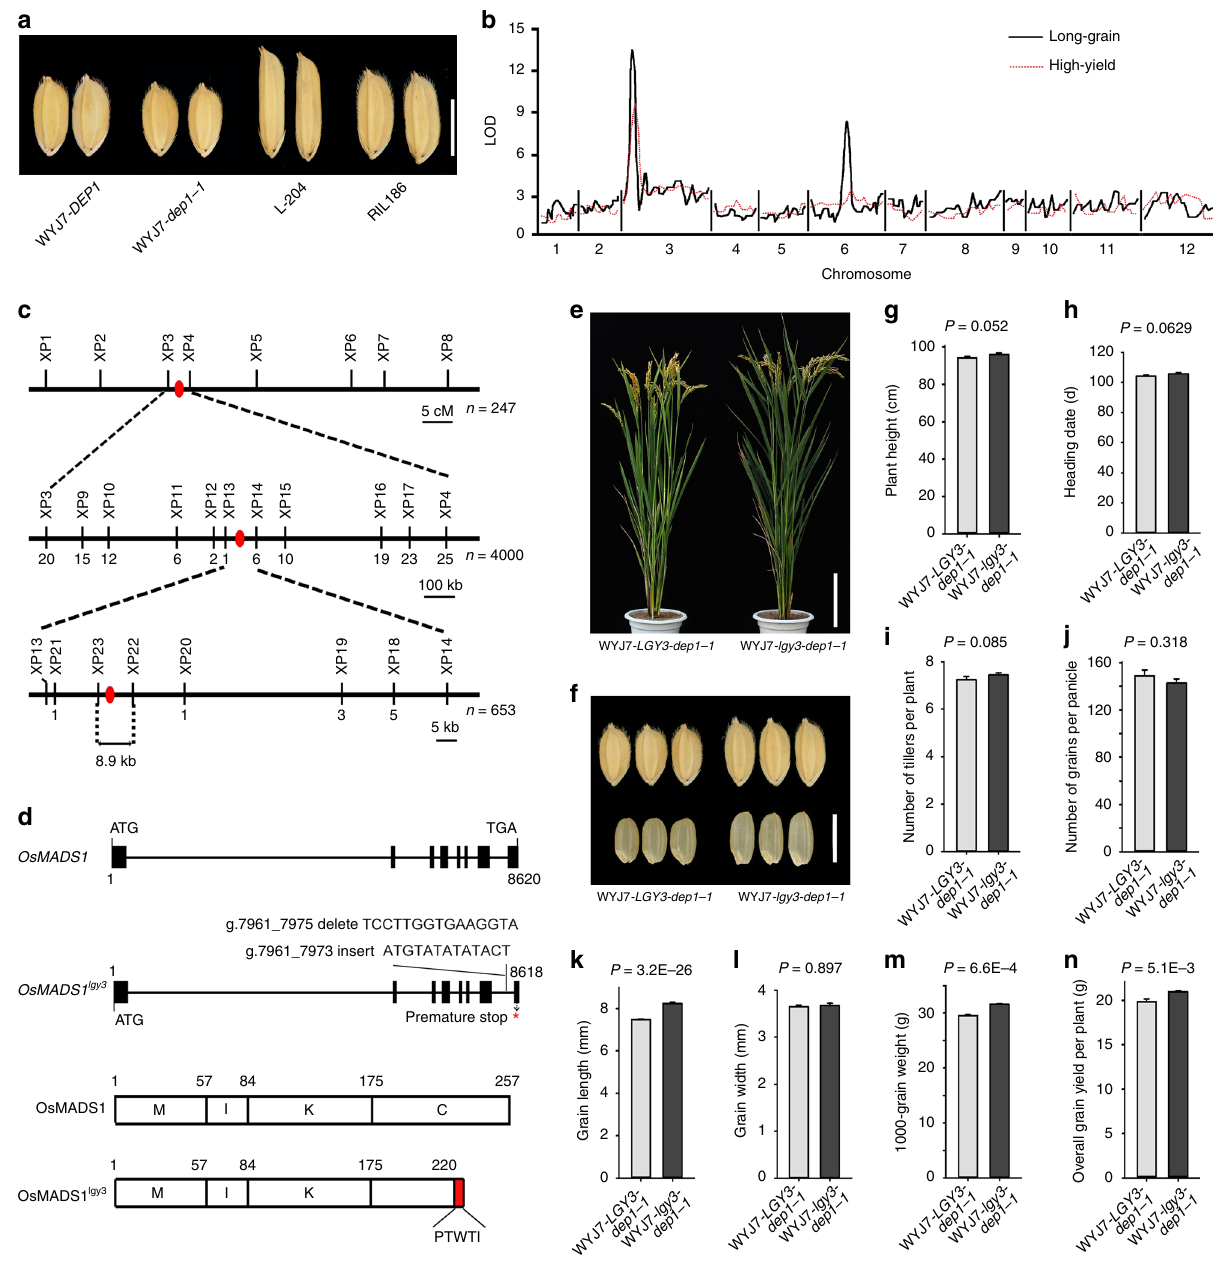
Fig. 1 The interaction between DEP1 and OsMADS1 regulates grain size and yield potential of rice. a Grain morphology. Scale bar: 5 mm. b QTL mapping for grain length and grain yield. c The positional cloning of qLGY3 . The candidate region was mapped to a ~ 8.9 Kbp genomic DNA region lying between markers XP22 and XP23. The numbers below the line indicate the number of recombinants recovered between qLGY3 and markers. d Allelic variations of OsMADS1 between RD23 and L-204. In the schematic illustration of OsMADS1 functional domains, M represents the MADS domain, I represents the intervening domain, K represents the keratin-like domain, and C represents the C-terminal domain. e The gross morphology of NIL plants. Scale bar: 15 cm. f Grain size and shape. Scale bar: 5 mm. g – n A fi eld-based comparison of the WYJ7- LGY3-dep1-1 and WYJ7- lgy3-dep1-1 plants: g Plant height; h Heading date; i The number of tillers per plant; j The number of grains per panicle; k Grain length; l Grain width; m 1,000-grain weight; and n The overall grain yield per plant. All phenotypic data were measured from the paddy-grown NIL plants grown under normal cultivation conditions. Data shown as mean ± s.e.m. ( n = 288). Student ’ s t -test was used to generate the P